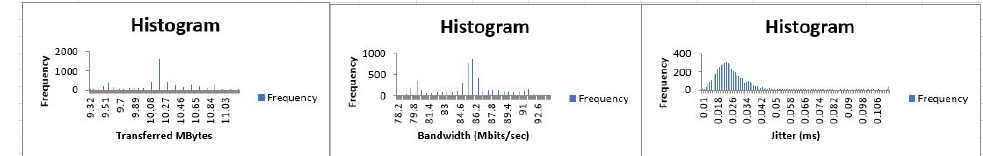
Figure 13. Node 1 with high data rate utilized bandwidth and